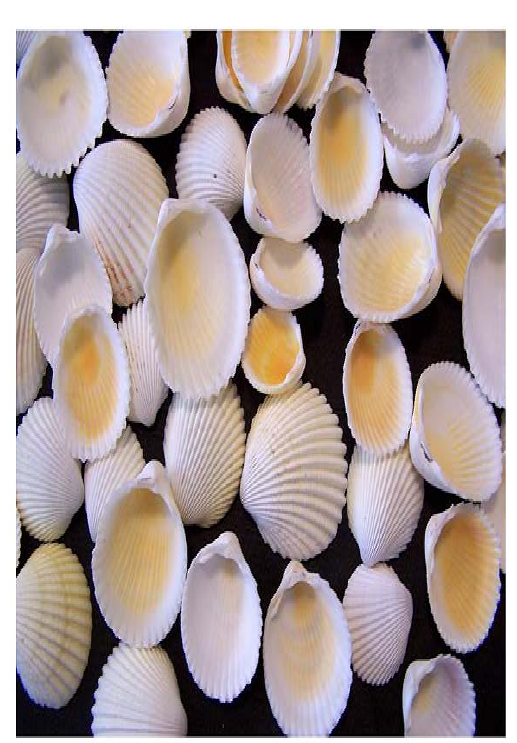
Fig. 1: Cockles shells as collected and